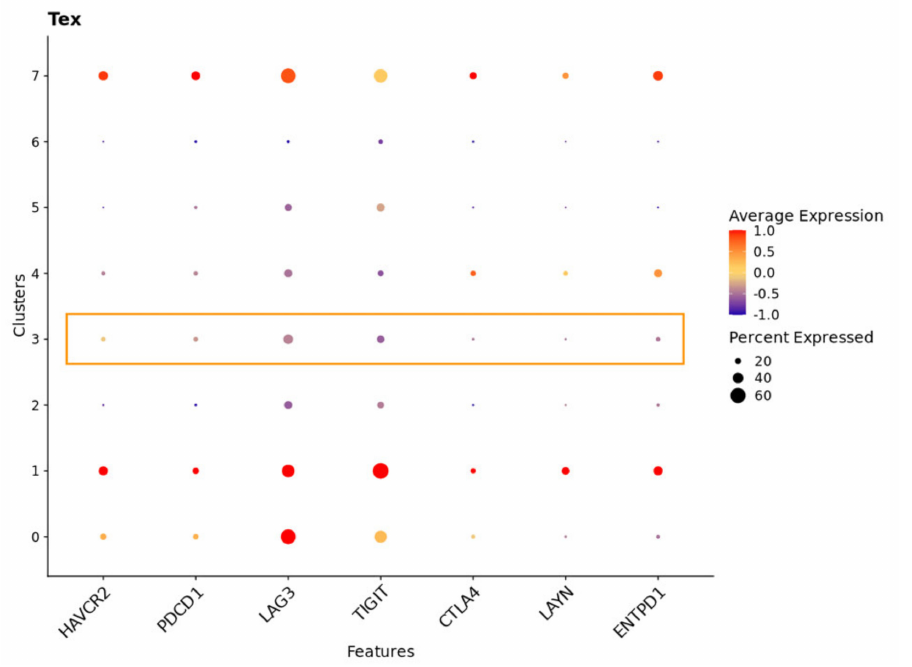
Figure 11. Cluster 3 of CD8+ T cell sub-clusters had the highest TBX21 expression associated with low levels of checkpoint receptors (PDCD1, LAG3, and TIGIT). The x -axis is the interested gene, with scaled average expression (low to high: − 1.0 to 1.0) and a larger dot indicating a higher percentage of expression of interested genes in the total analyzed cells. The y -axis is the identified CD8+ T cell